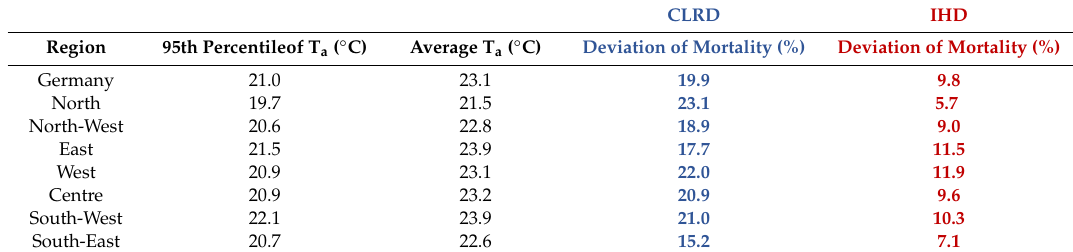
Table 3. Deviation of CLRD (blue) and IHD (red) mortality during heat waves based on T a . Significant deviations on 95% level ( α = 0.05) are marked in bold.